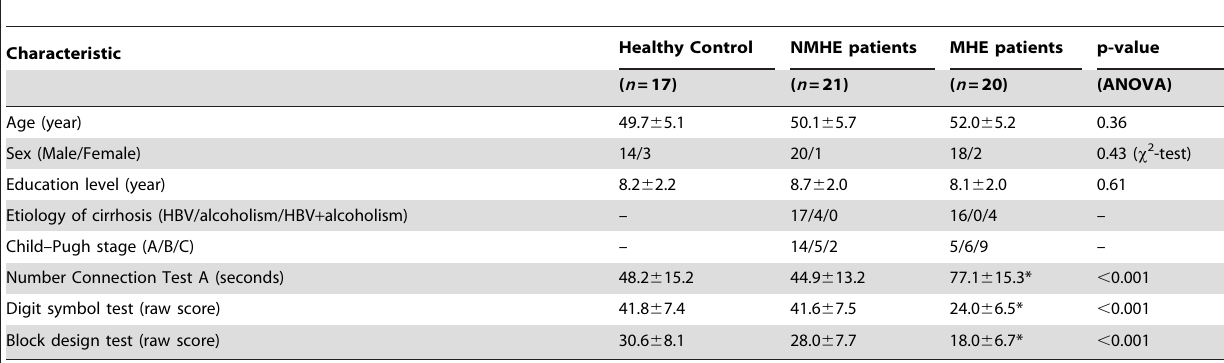
Table 1. Demographic and clinical characteristics of